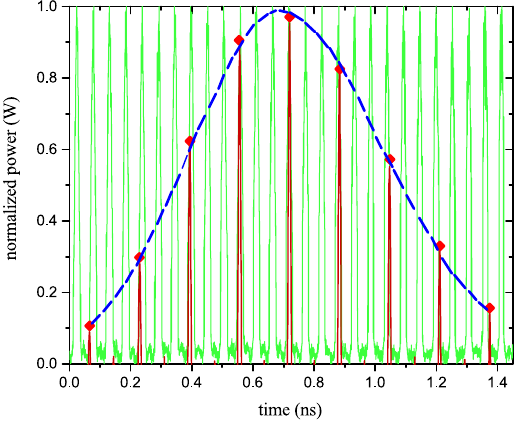
Figure 5. Stretching and sampling of the 15.55 ps input pulse (60 GHz). The signal copies at the output of the ring resonator (green) are multiplied with a sinc pulse sequence (red) by convolution in the frequency domain with a nine-line frequency comb with Δ f s = 12.23 GHz. For better visualisation, the pedestal was removed, the output copies were normalized to the one with the highest amplitude and the sampling pulses were multiplied with the corresponding normalization factor. Since the ring behaves equally for all input signals, this can be done by post-processing of the data. The sampling points (red diamonds) are retrieved by an integration of the sampling pulses over their repetition time. Due to limitations of the PLL, the sampling frequency was not close to the repetition rate of the replicas Δ f R = 18.774 GHz. Consequently, only every third copy could be sampled and every second sampling pulse is in the gap between two copies (small red lines). The stretched pulse is the envelope over the sampling points and has a stretching factor of Δ S =